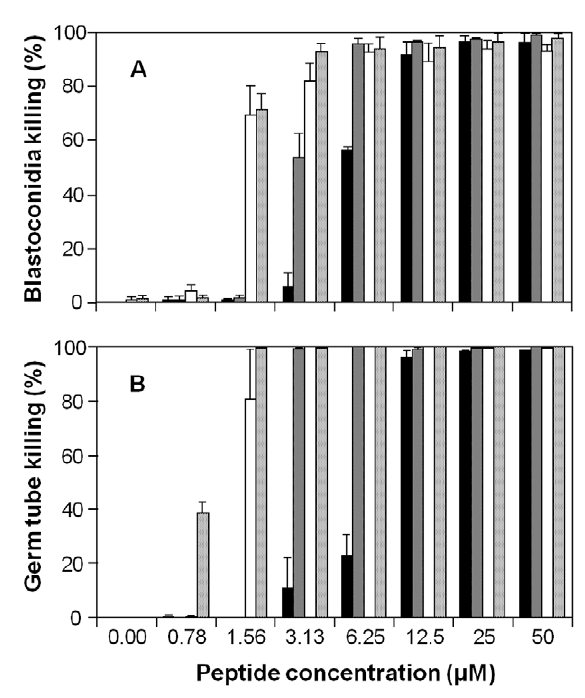
Figure 4. Killing activity of recombinant histatin 3 mers. A, C. albicans blastoconidia killing. Cells were grown to exponential phase in J strength Sabouraud dextrose broth; B, Germ tube killing. Formation of germ tubes was induced by incubating blastoconidia in RPMI-1640 for 3 hr at 37 u C. Killing was determined for peptide concentrations between 0 and 50 m M after an incubation time of 60 min at 37 u C. Black bars, reHst3 1-mer; crosshatched bars, reHst3 2-mer; white bars, reHst3 3-mer; dotted bars, reHst3 4-mer. The experiments were performed in triplicate. The average and standard deviation (SD) of a representative experiment is shown. doi:10.1371/journal.pone.0051479.g004 of histatin 3, one or more functional domains, and the C-terminal 7 residues of native histatin 3. A recombinant fragment containing one functional domain was obtained using primers S-1 and AS-3 and a previously isolated histatin 3 expression plasmid (pHst3) as